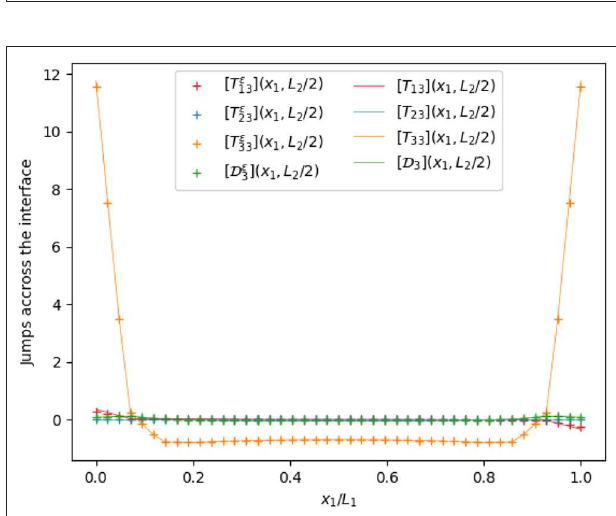
FIGURE 12 | Jumps of the traction vector and normal electric displacement across the interface on a line along the x 1 axis, with ε/ h = 0.1.